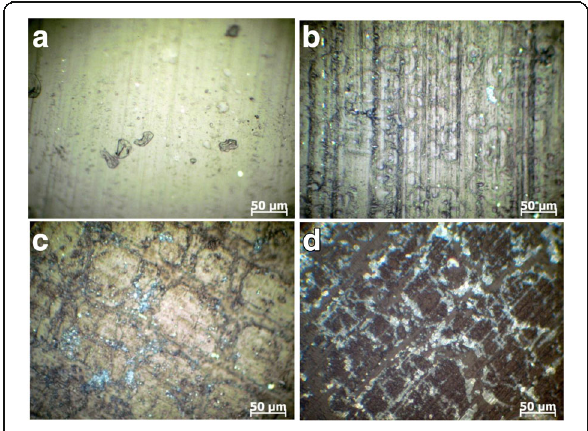
Fig. 6 Reflective optical microscopy results. ROM of the epoxy polymer with a 0, b 10, c 20, and d 50 phr LiClO 4 salt